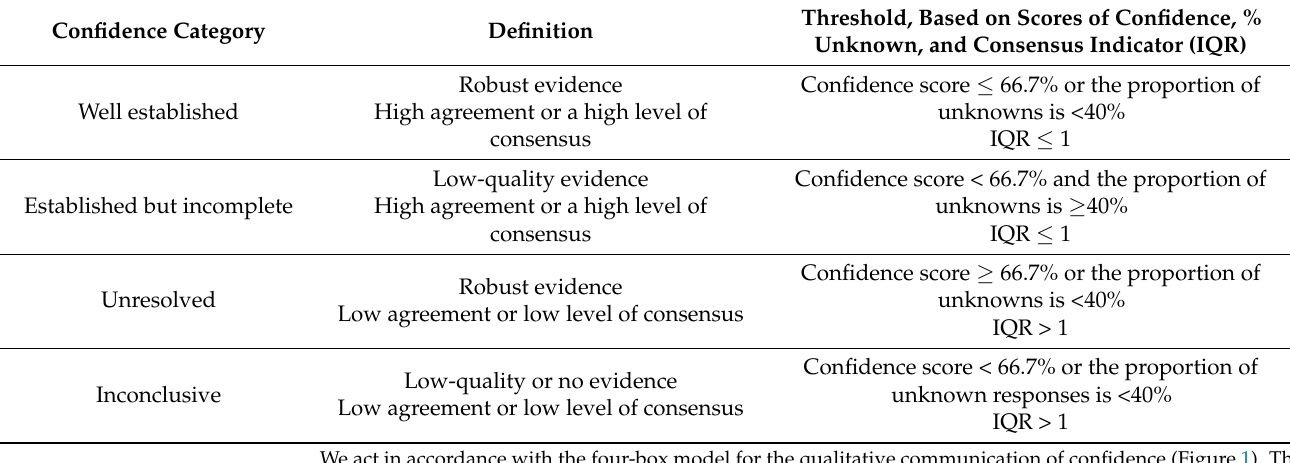
Table 4. Communication on the gradation of